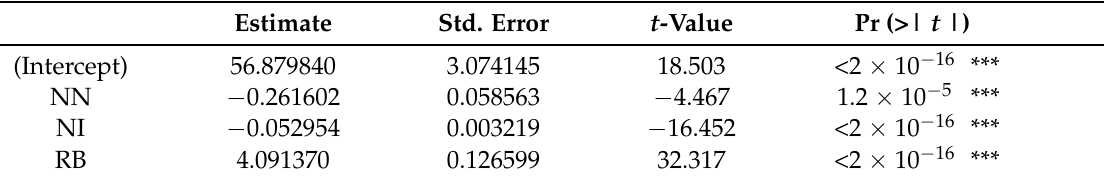
Table 4. Model 2 (ANOVA